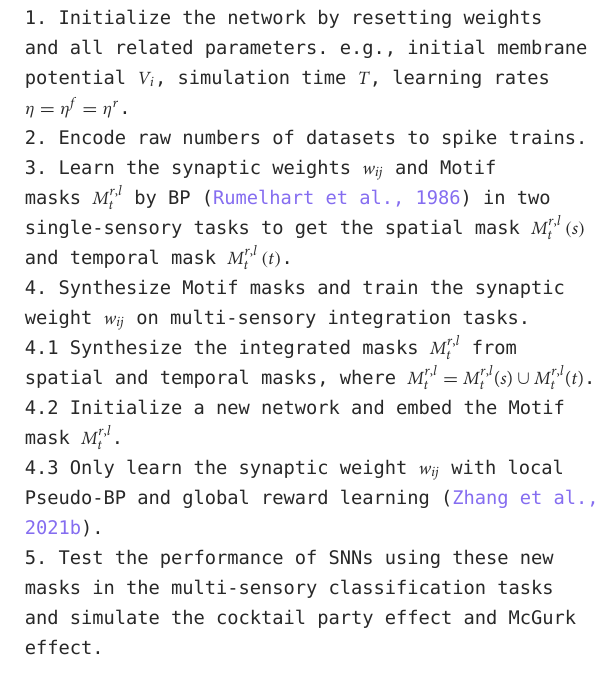
Algorithm 1. The M-SNN